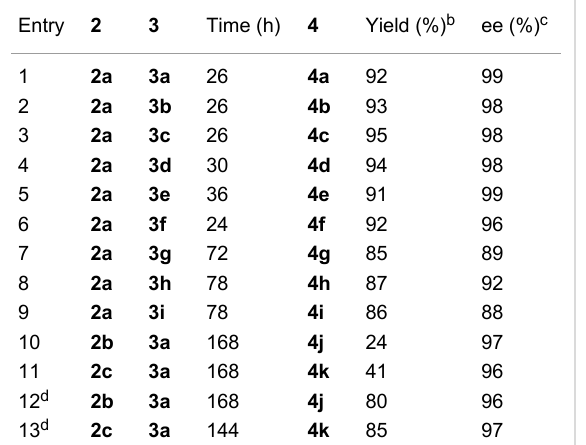
Table 5: Substrate scope of 1a D-CSA catalyzed asymmetric Michael reaction of ketones 2 with isatylidenemalononitrile derivatives 3 . a